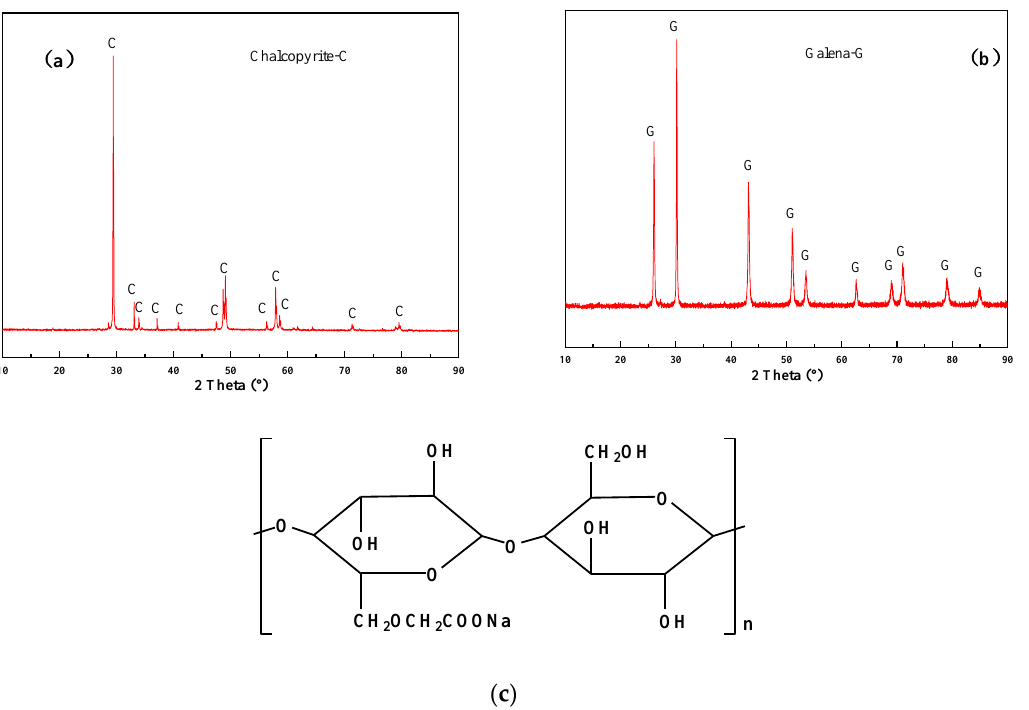
Figure 1. XRD pattern of ( a ) chalcopyrite and ( b ) galena; ( c ) the structure of CMC. Table 3. The mineral composition of the copper–lead bulk concentrate (wt %).